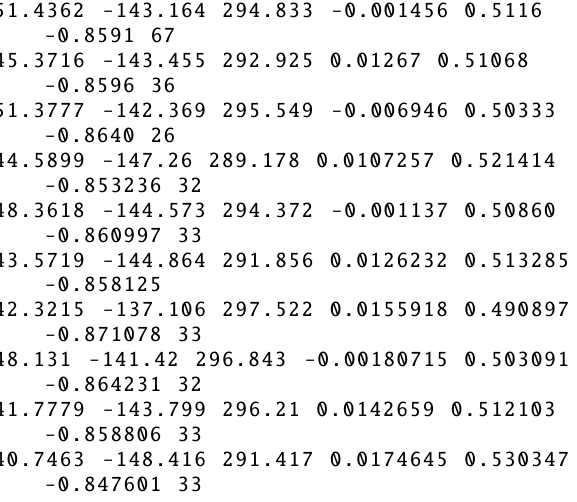
Figure 6. Path traced by the user during the experience with the AR application.